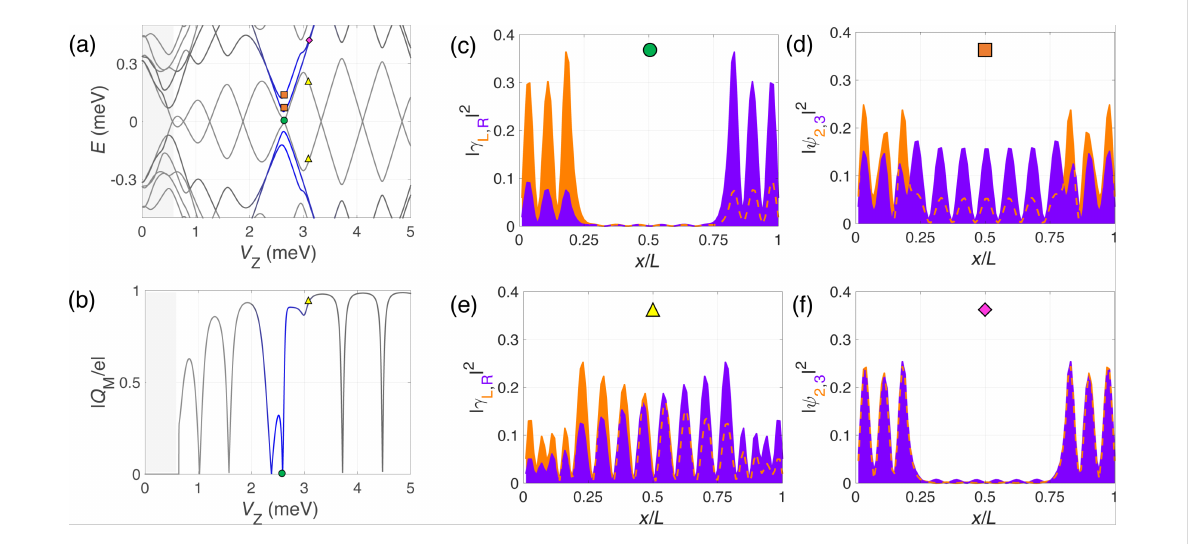
Figure 6: Evolution with Zeeman field of the spectrum (a) and the absolute value of the Majorana charge Q M (b) for the barrier-like potential model of Figure 5b. Panels (c) and (e) show the wave-function probability profile (in the Majorana basis) of the two lowest-energy states at the V Z values indi- cated in (a). Panels (d) and (f) show the same but for the second and third energy states (QD-like states). At the QD–Majorana levels anticrossing, the Majorana wave function leaks into the dot regions leaving the topological region of the wire practically void. This is manifested in | Q M | by two consecu- tive zeros, one per dot level (around V Z = 2.5